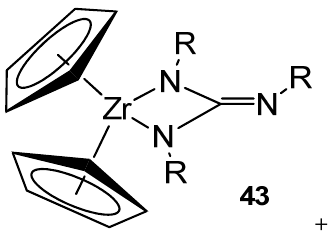
Figure 26. Dianionic zirconium guanidinato complex.